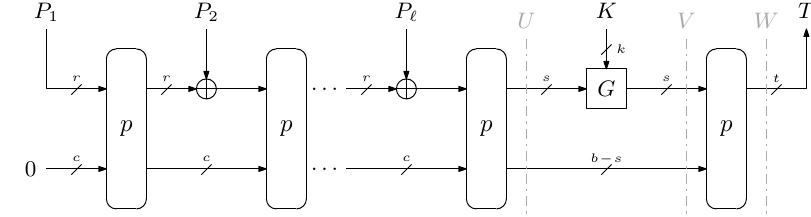
Figure 1: The suffix keyed sponge. The plaintext P is first injectively padded into r -bit blocks P 1 . . . P ‘